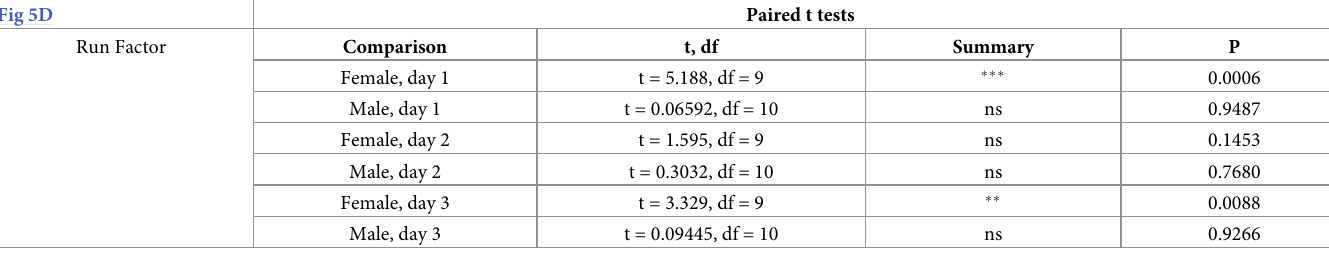
Table 7. Statistical analysis of data shown in Fig 5D for place reversal, cohort A, Run comparison. Fig 5D Paired t tests Run